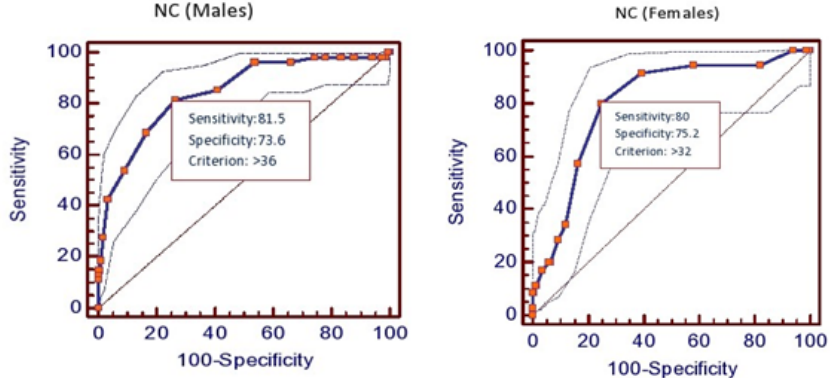
Figure 2. ROC Curve for NC cut off for determining high risk of OSA in males &